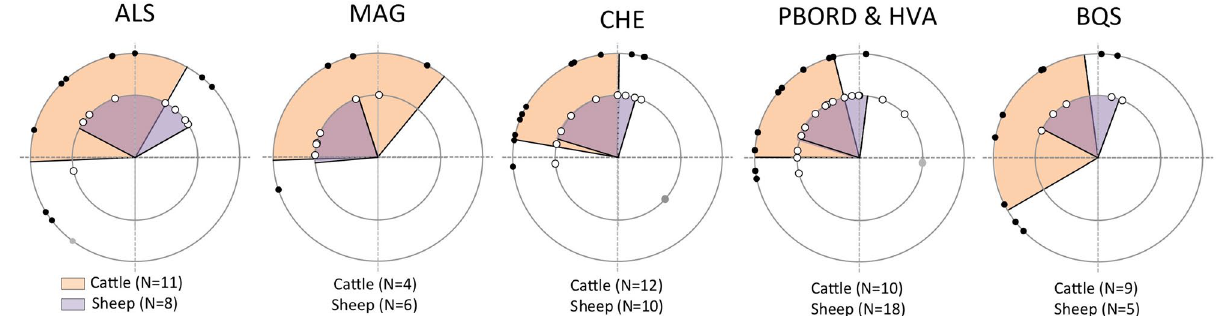
Figure 4. Distribution of cattle and sheep births throughout the annual cycle. CHE: Cheia (sheep data in 85 ); PBORD & HVA: Borduşani and Hârşova (sheep data in 84 ); BQS: Bercy (sheep data in 15 ); MAG: Măgura (cattle: corrected data from upper molars; sheep data in 16 ), ALS: Alsónyék (cattle: corrected data from upper molars; sheep data in 84 ). Note that the time of the year when calving and lambing occurred may not be directly compared on these graphs. BQS sheep data on M2; all others: data on